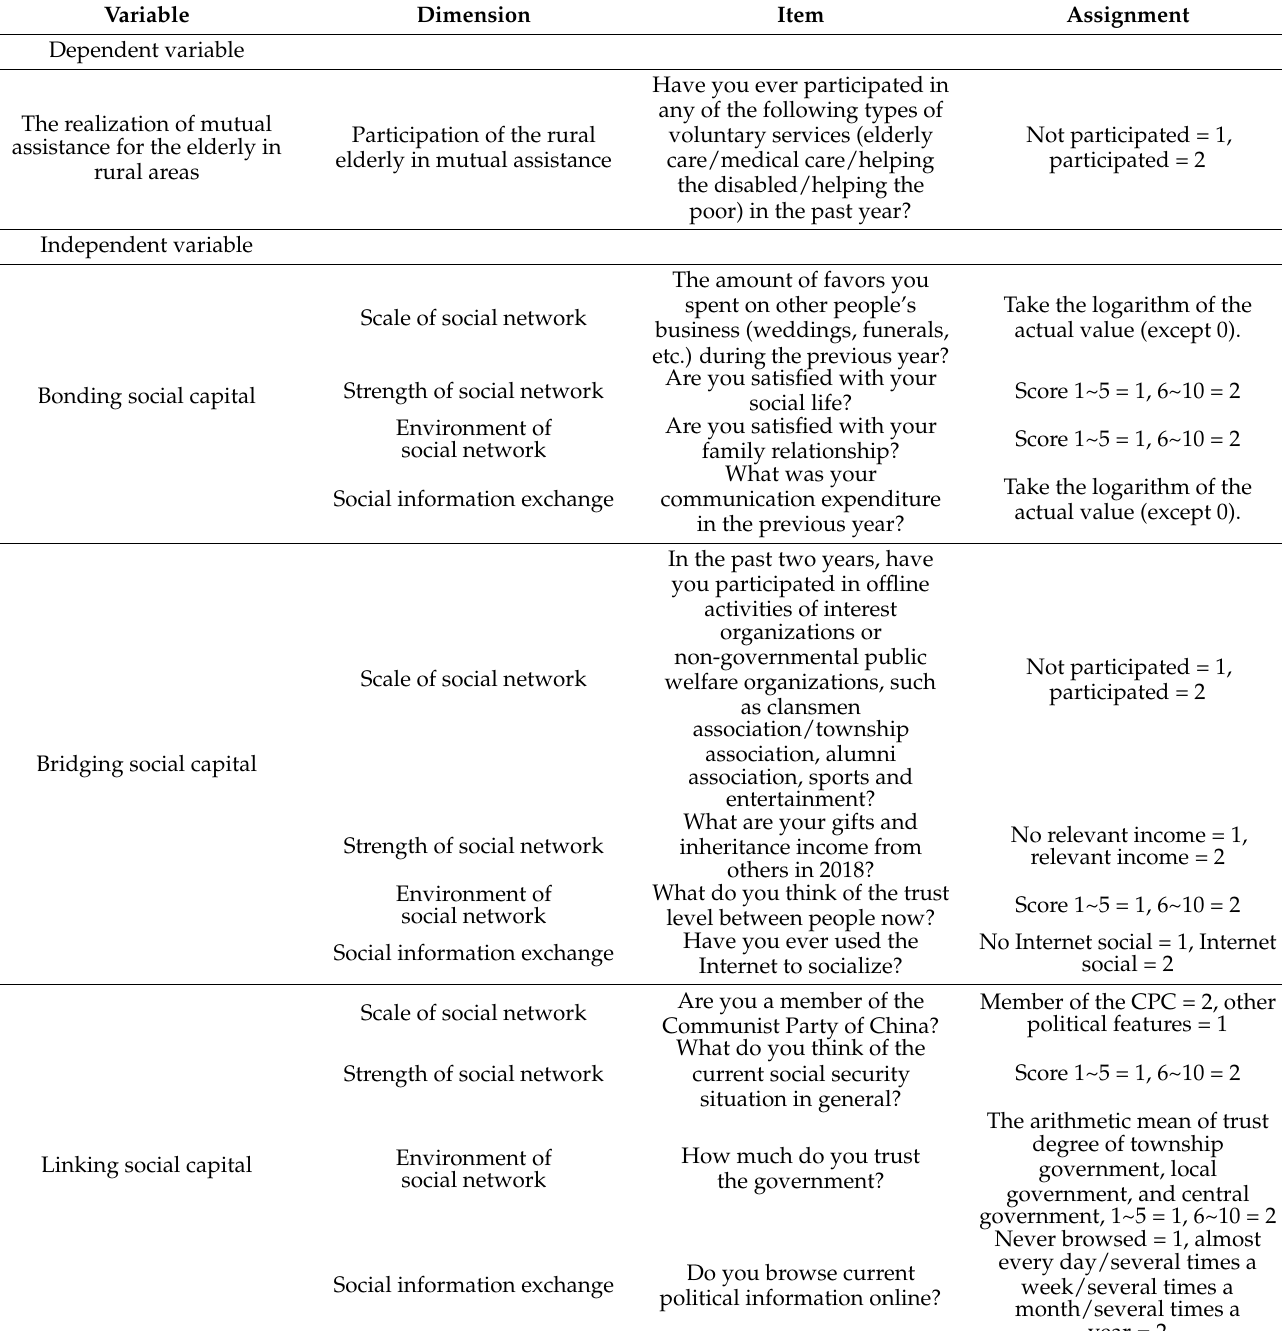
Table 2. Description of core